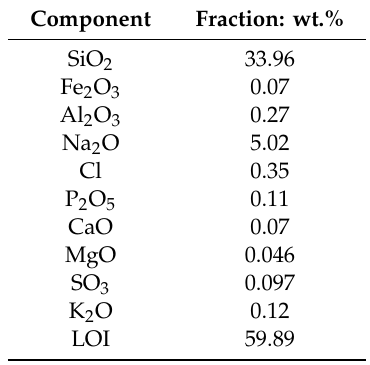
Table 3. Chemical composition of colloidal